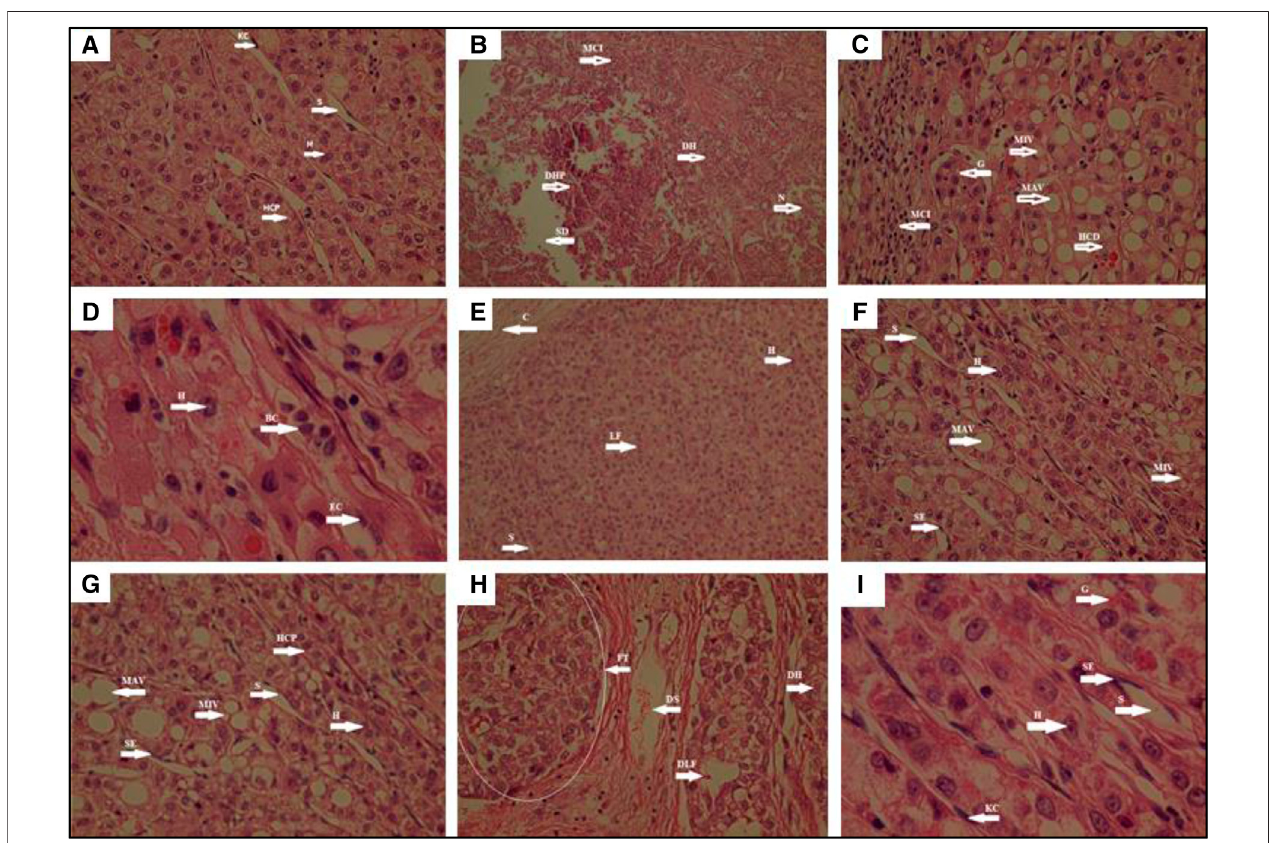
FIGURE 5 | Histopathological view of hepatic tissue in the control, hypercholesterolemia, test materials and reference drug Atorvastatin administered animals. Tissuesectionswasstainedthehematoxylinandeosin(HE). Theoriginalmagni fi cationwas × 100.Dataarerepresentativeofsixanimalpergroup (A) :Controlgroup; (B) : Hypercholesterolemicgroup; (C) :BentoniteGroup; (D) :GBTFGroup; (E) :GBTPGroup; (F) :GBTGroup; (G) :FlaxseedGroup; (H) :PsylliumGroup; (I) :Atorvastatin.BC, Blood cell in sinusoid; C, Capsule; DH, Degenerative hepatocyte; DHP, Degenerative Hepatocyte plague; DLF, Degenerative lobular formation; DS, Degenerative sinusoid; E, Endothelium; EC, Endothelialcell; FT, Fibrous tissue; G, Granuloma; H, Hepatocyte; HCD, Hepatocyte cell degeneration; HCP, Hepatocyte cell plague; KC, Kupffer cell; LF, Lobular formation; MCI, Mononuclear cell in fi ltration; MAV, Macrovesicle; MIV, Microvesicle; N, Necrosis; S, Sinusoid; SD, Sinusoid degeneration; SE, Sinusoid